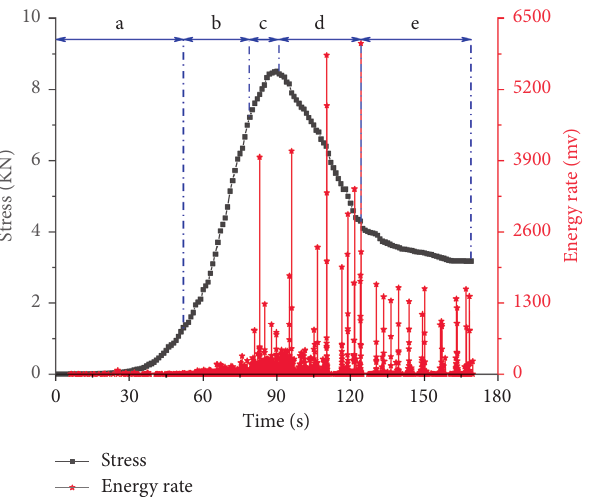
Figure 7: Stress-time curve and AE energy rate-time curve of backfill under uniaxial compression.